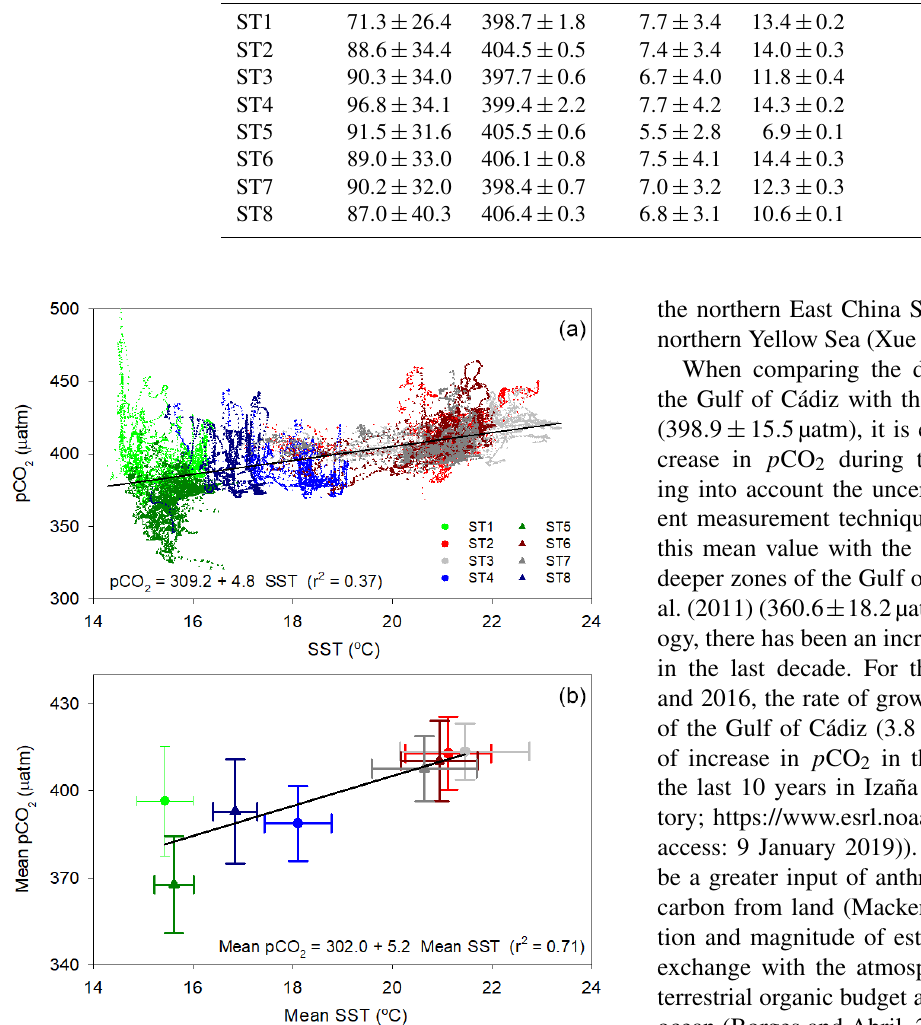
Figure 5. Dependence of p CO 2 with sea surface temperature (SST) for the complete underway database during all the cruises (a) and for the mean values of p CO 2 and SST for each cruise showing their standard deviations (b) . The solid line shows the linear